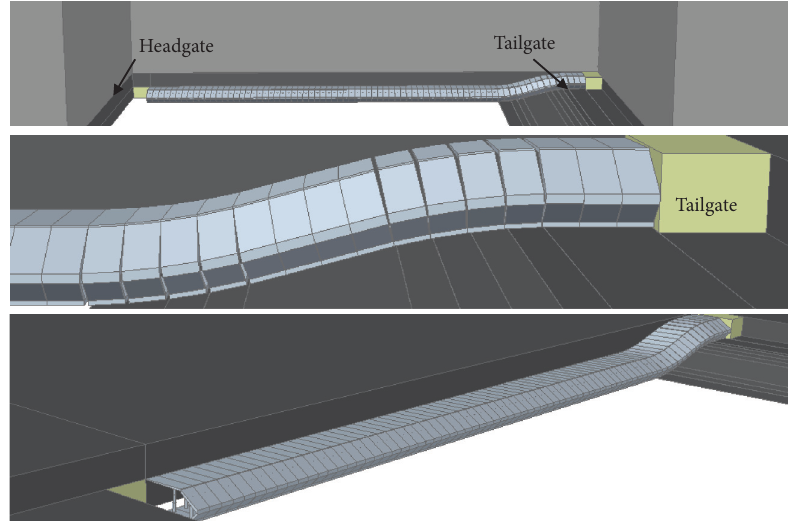
Figure 5: 3-D views of one SLL panel [1].